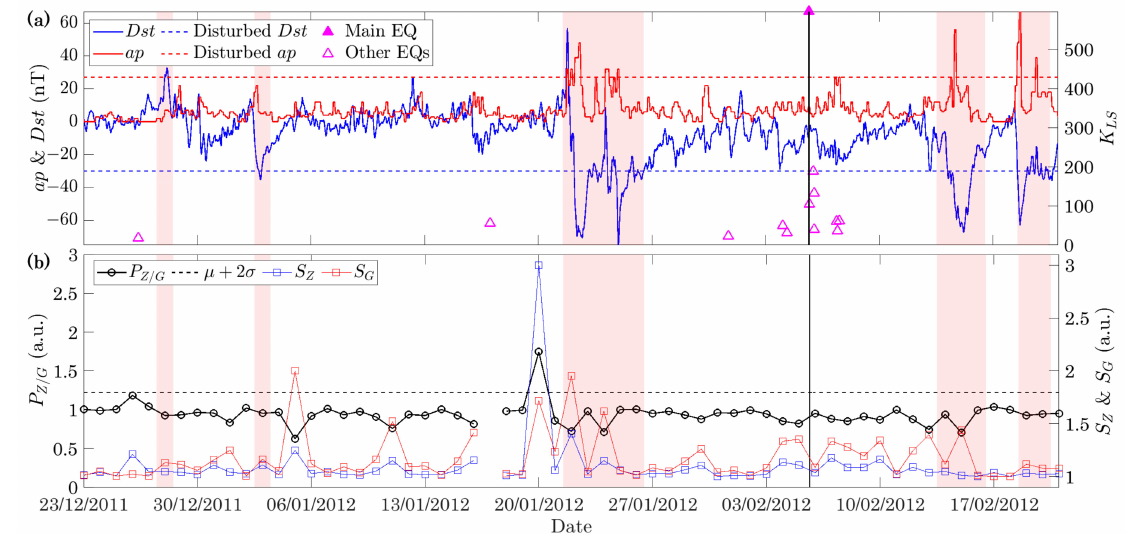
Figure 3. Temporal evolution of ( a ) ap & Dst indices (left axis) and K LS of nearby earthquakes (right axis), and ( b ) P Z / G parameter and its µ + 2 σ threshold (left axis), and individual S Z and S G (right axis) at CEB station (December 2011–February 2012). Disturbed days, in which either ap or Dst exceeds their respective disturbed threshold, are shaded red.